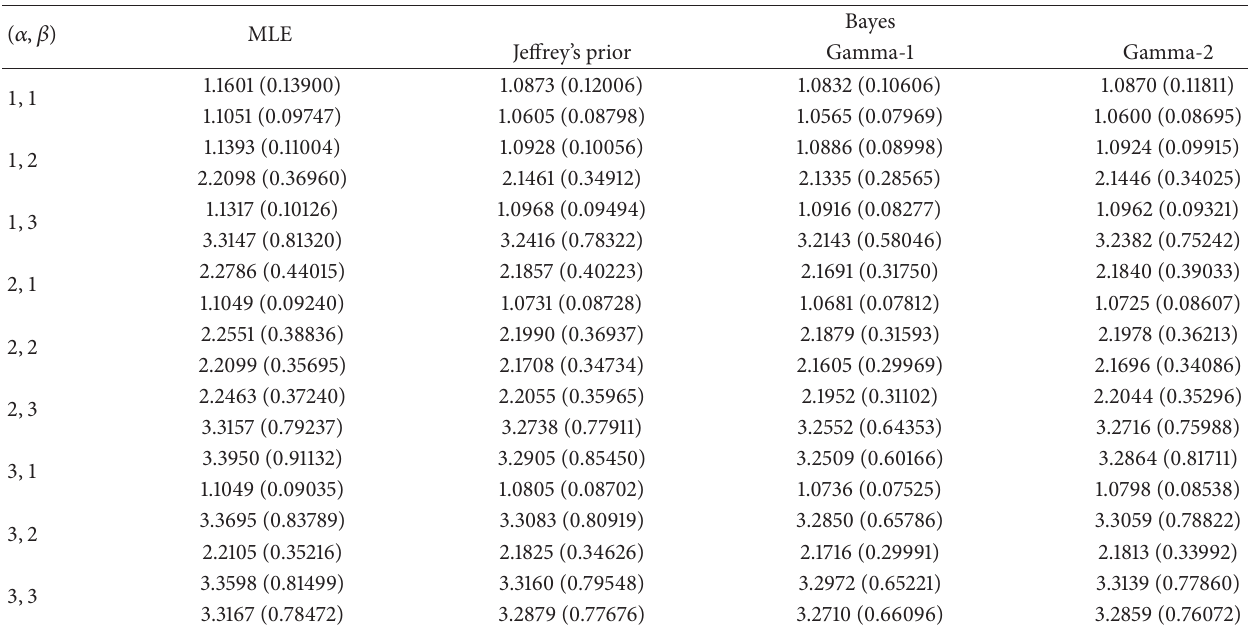
Table 3: Average estimates and MSEs (in the brackets) of the estimators of 𝛼 (in the first row of each cell) and 𝛽 (in the second row of each cell) for fixed 𝑛 = 20 , 𝑟 = 16 with varying